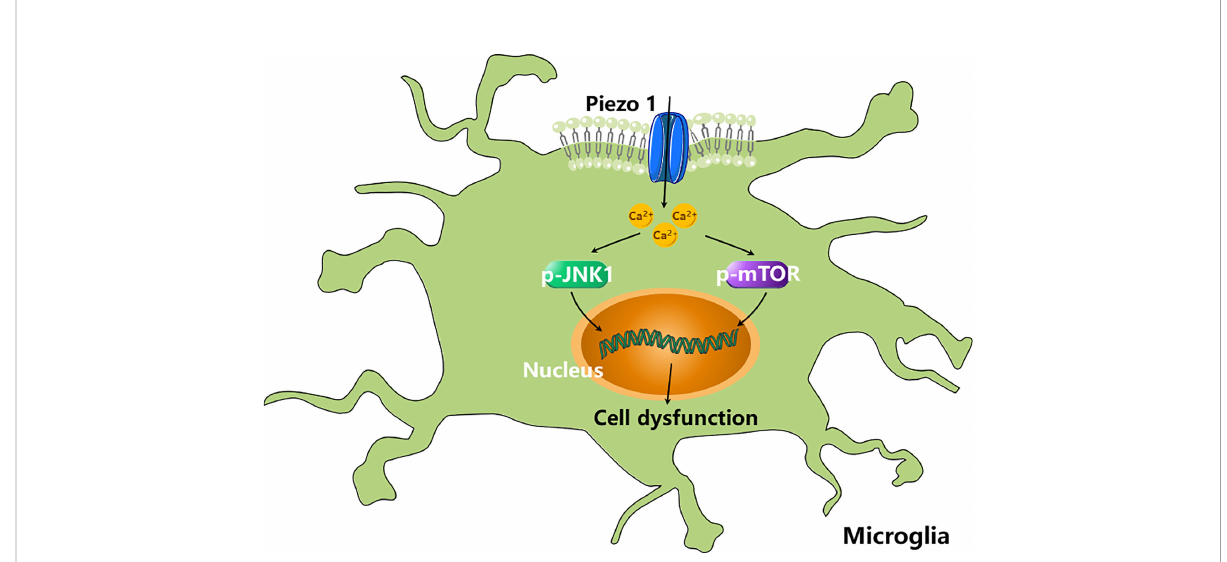
FIGURE 3 Piezo1 activation modulates microglial activity. High concentration of glucose (HCG) increases the expression of Piezo1 in microglia, which increases cytosolic Ca 2+ signalling and reduces the phosphorylation of mTOR and JNK1, triggering cell dysfunction